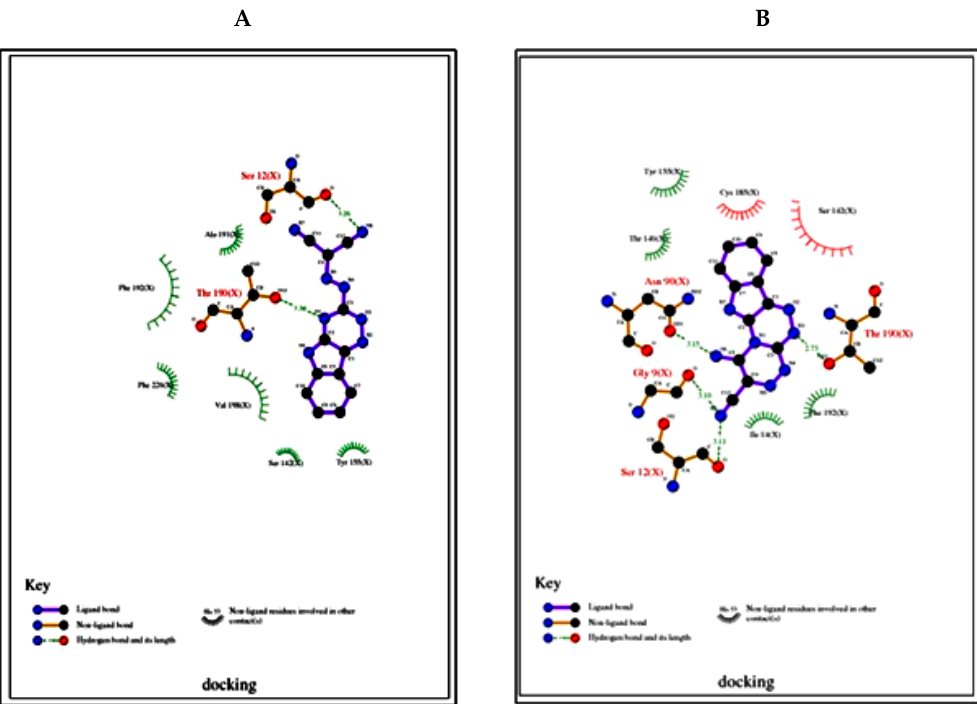
Figure 6. ( A ). 2D plot of interaction between the compound 3 and receptor breast cancer (3hb5); ( B ). 2D plot of interaction between the compound 4 and receptor breast cancer (3hb5).